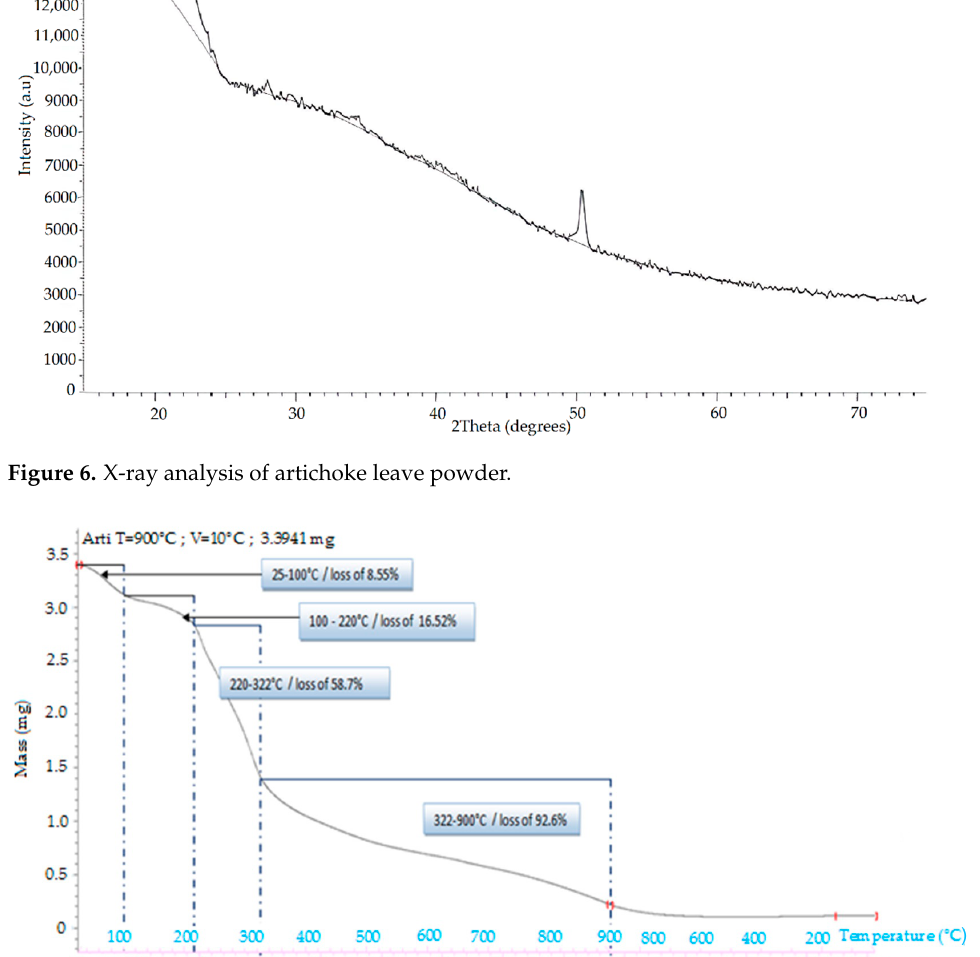
Figure 8. p H value of the point of zero charge (pH pzc ) for raw ALP bio-sorbent. In all the experiments, the pH of solutions were maintained constantly equal to 4, therefore, the surface of bio-sorbent (ALP) can be considered positively charged. (pH solution < pH pzc ). 2